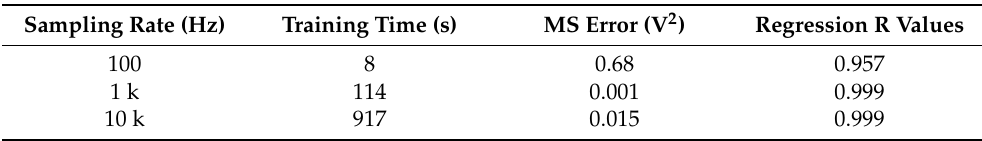
Table 1. The modeling accuracy of the proposed multi-layer feedforward neural network (MFNN) model using different n